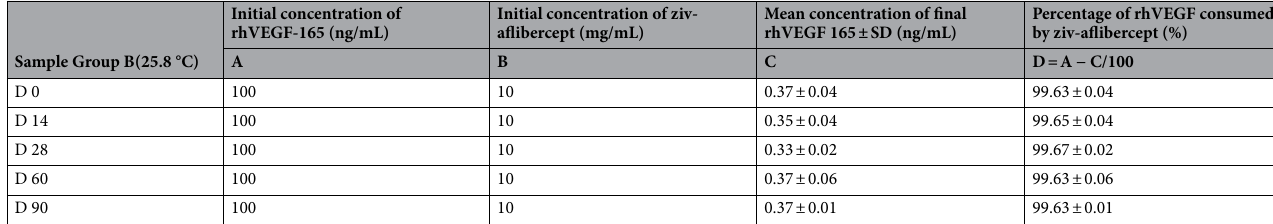
Sample Group B(25.8 °C)